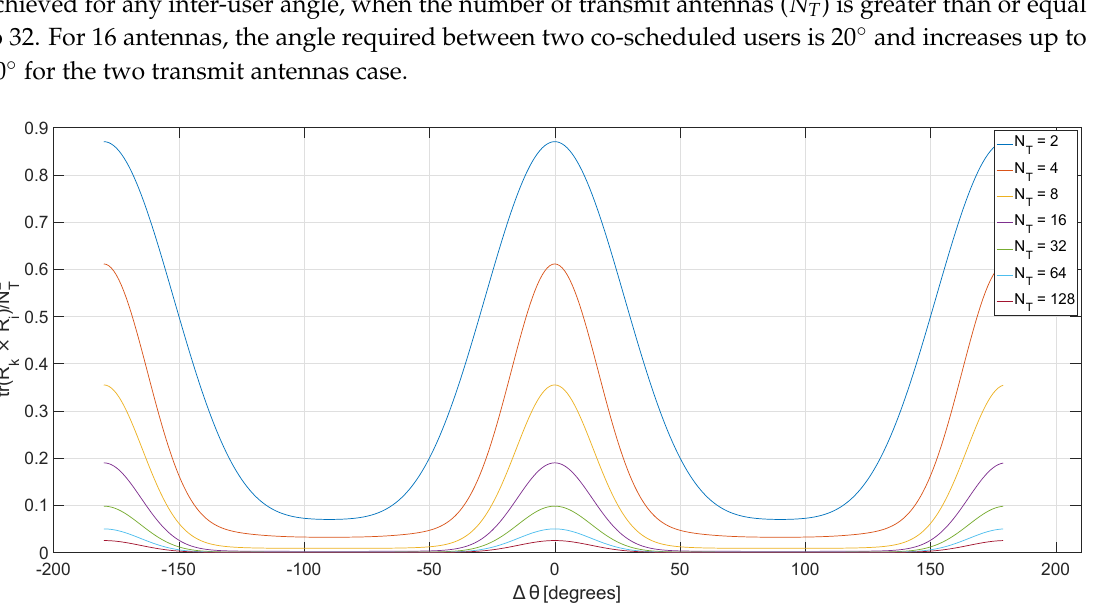
Figure 5. Channel separation as a function of the angle between user k and i , for δ following a Gaussian